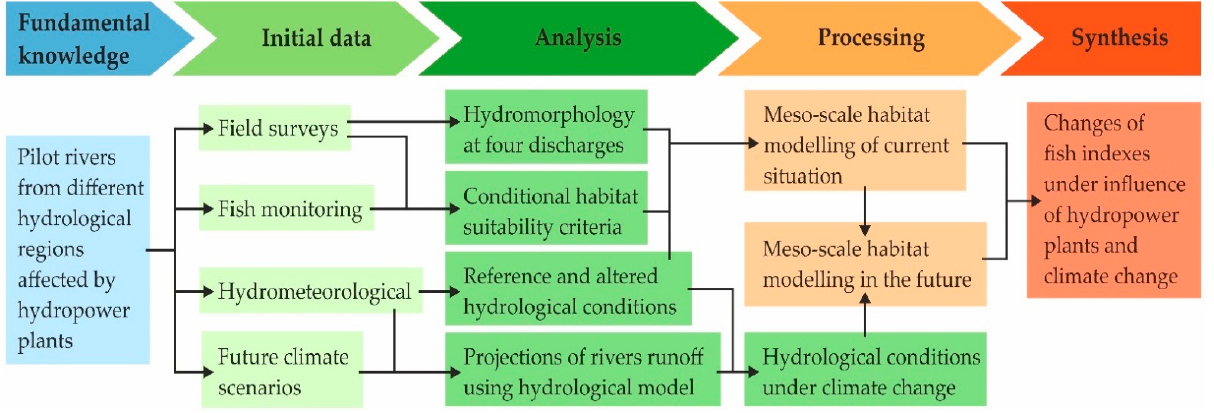
Figure 2. Workflow of the current study.